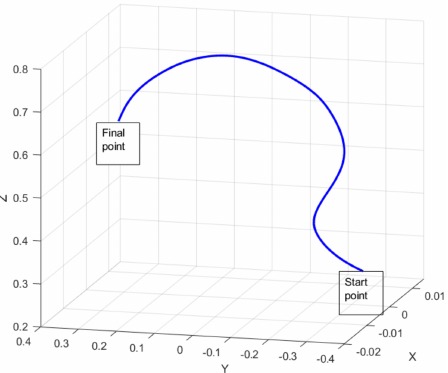
Figure 11. Improved trajectory visualization.